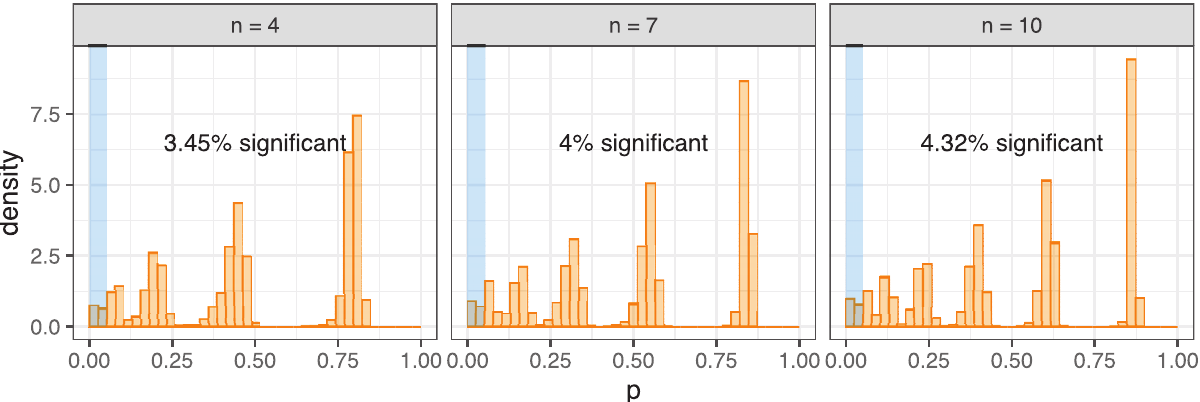
Fig 3. Calibration of the exact gene pair placement test. For the exact test on the simulated data of Fig 2 we observe conservative p-values at lower significance levels, and very pronounced discrete effects for larger values.